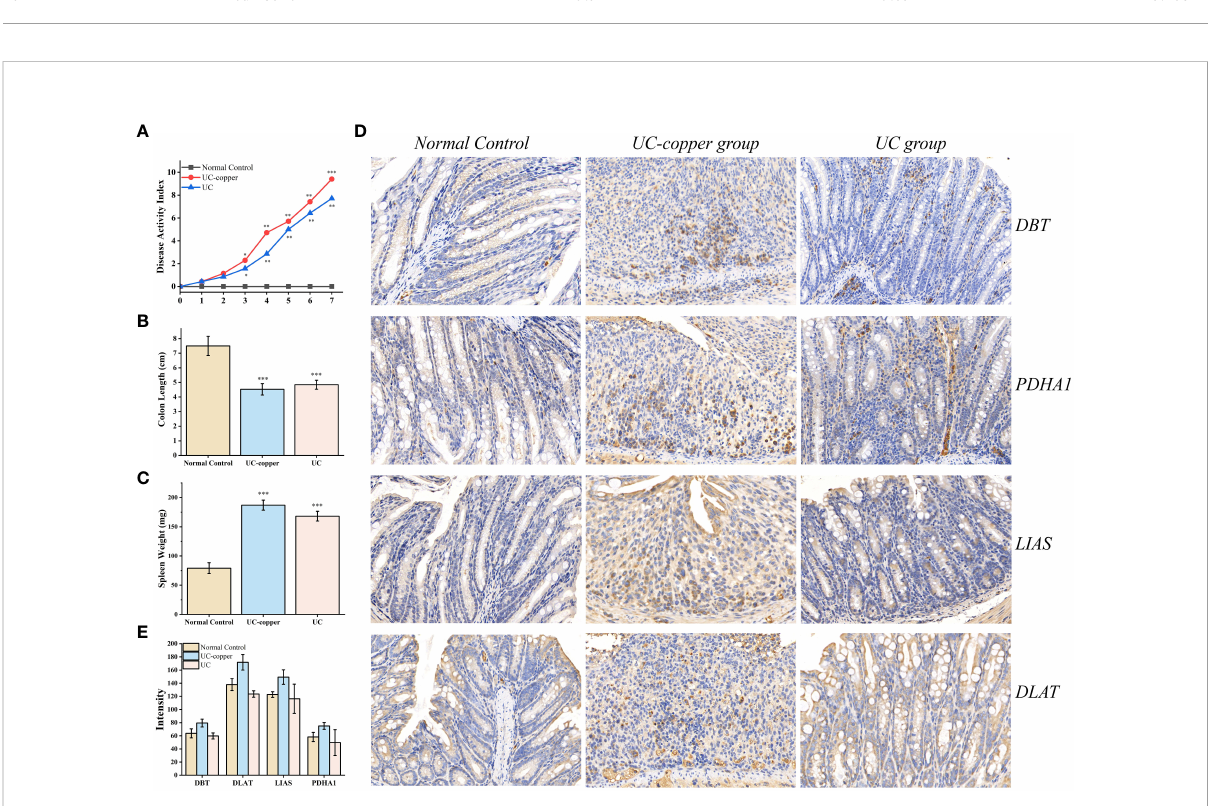
FIGURE 6 Experimental determination of cuproptosis in DSS-induced UC mice. (A) Dynamic changes of the disease activity index at indicated time points. Asterisks indicate signi fi cances: *p ≤ 0.05, **p ≤ 0.01, ***p ≤ 0.001. (B, C) Differences in spleen weight and colon length between groups. (D) Immunohistochemical staining for PDHA1, DBT, DLAT, and LIAS in the distal colonic tissue of each mouse (×20 magni fi cation). (E) Comparison of IHC intensity between groups to detect the expression of the four